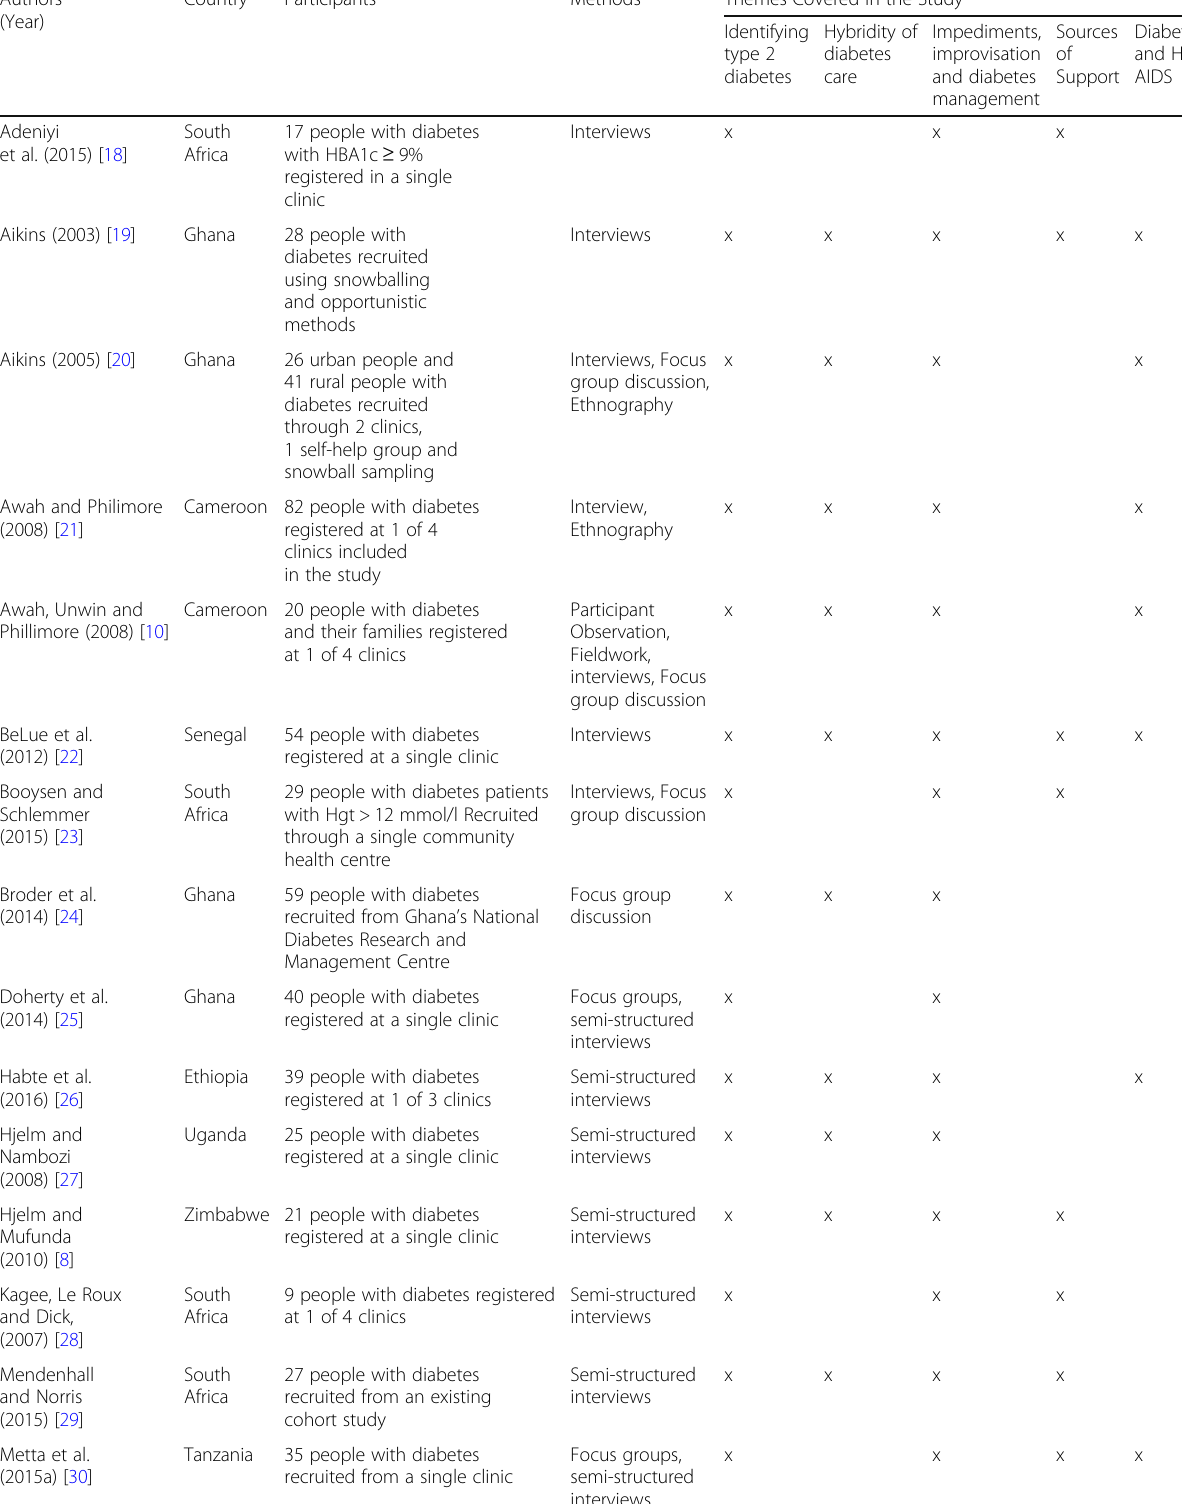
Table 2 Studies included in the scoping